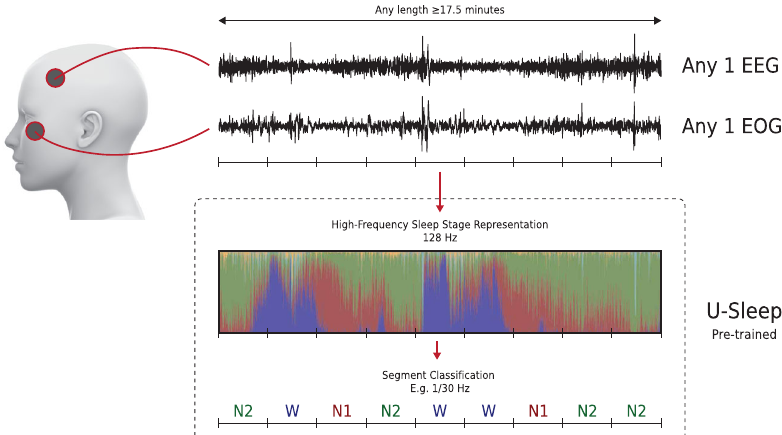
Fig. 1 The U-Sleep prediction pipeline. U-Sleep is a ready-to-use deep neural network for sleep staging. First, it maps each provided EEG and EOG channel pair (shown in the top) to an intermediate, high-frequency sleep stage representation (shown in the middle). The intermediate representation is visualized by the colored bars indicating the level of con fi dence U-Sleep has that the subject is in one of the 5 sleep stages at a given time (Blue: Wake, Red: N1, Green: N2, Cyan: N3, Yellow: REM). From the intermediate representation, U-Sleep aggregates con fi dence scores over periods of time (for instance segments of 30 s) to output fi nal sleep staging scores. U-Sleep makes no assumptions about the PSG protocol including acquisition hardware, electrode positions, fi ltering, and sampling rate. Internally, signals are re-sampled at 128 Hz. U-Sleep may output sleep stage labels up to this frequency.